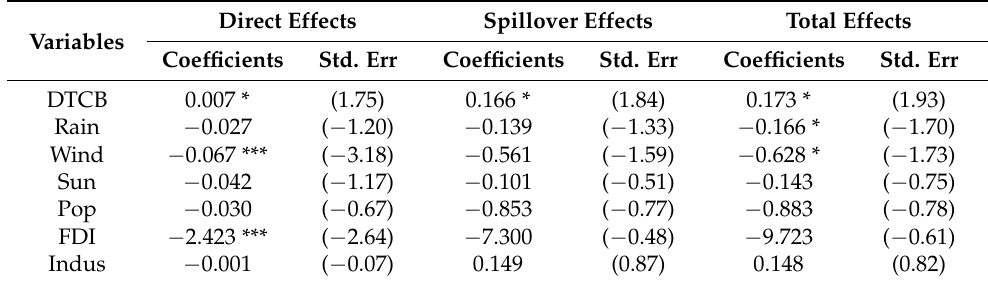
Table 6. Robust test of replacing core explanatory